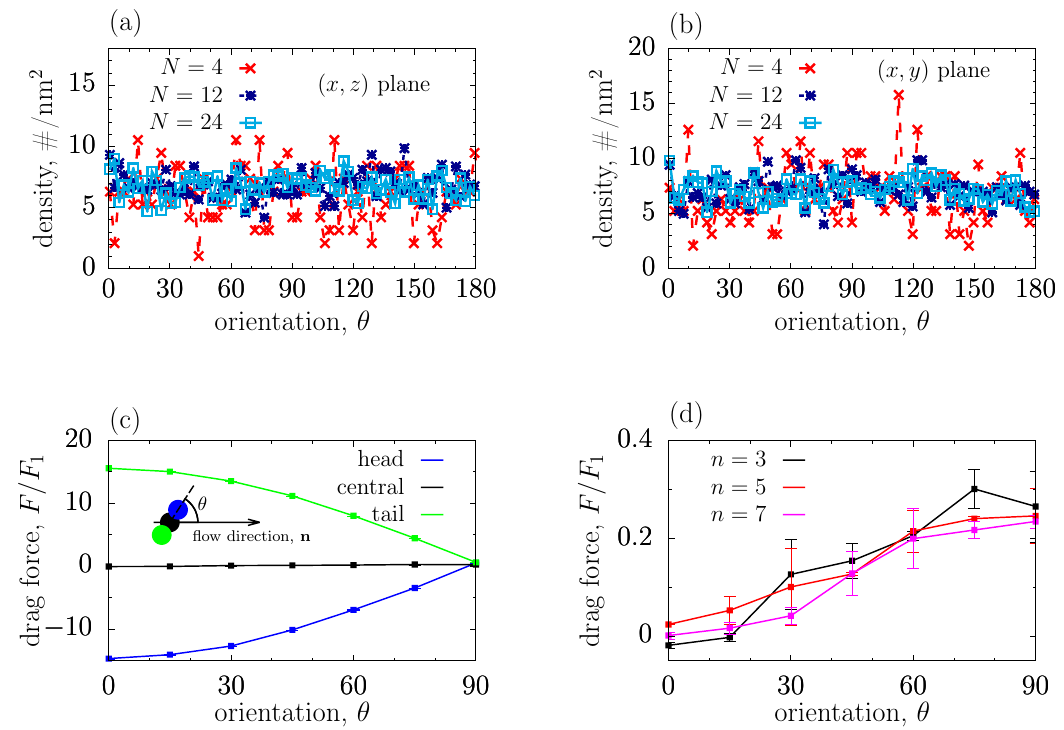
Figure 3. Near bead orientation and flow shielding. ( a , b ) Orientation distribution of the nearest bead in a polymeric coating within the ( x , z ) and ( x , y ) planes (see Figure 1a) for different degrees of polymerization; ( c ) Drag force acting on the beads in a three-bead configuration as a function of orientation in the ( x , z ) plane. The positions of all beads are fixed and the beads are not allowed to fluctuate. The drag force is expressed in terms of the drag acting on the bead in the absence of other beads, F 1 4.7 kJ/(mol nm); ( d ) Drag force acting on the central bead for different numbers of beads ≈ in a